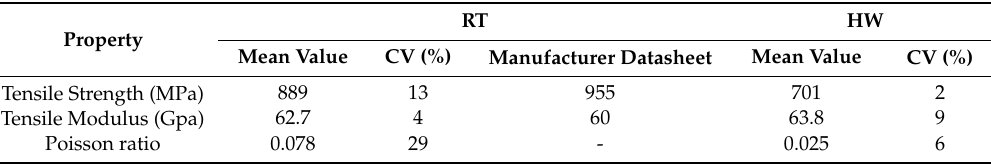
Table 3. E ff ect of hot-wet storage aging on mechanical properties derived from static tension tests on warp-directional laminates.